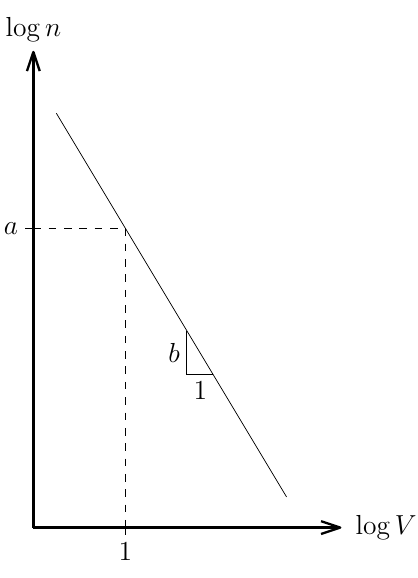
Figure 1. Sketch of a n = aV − b power law